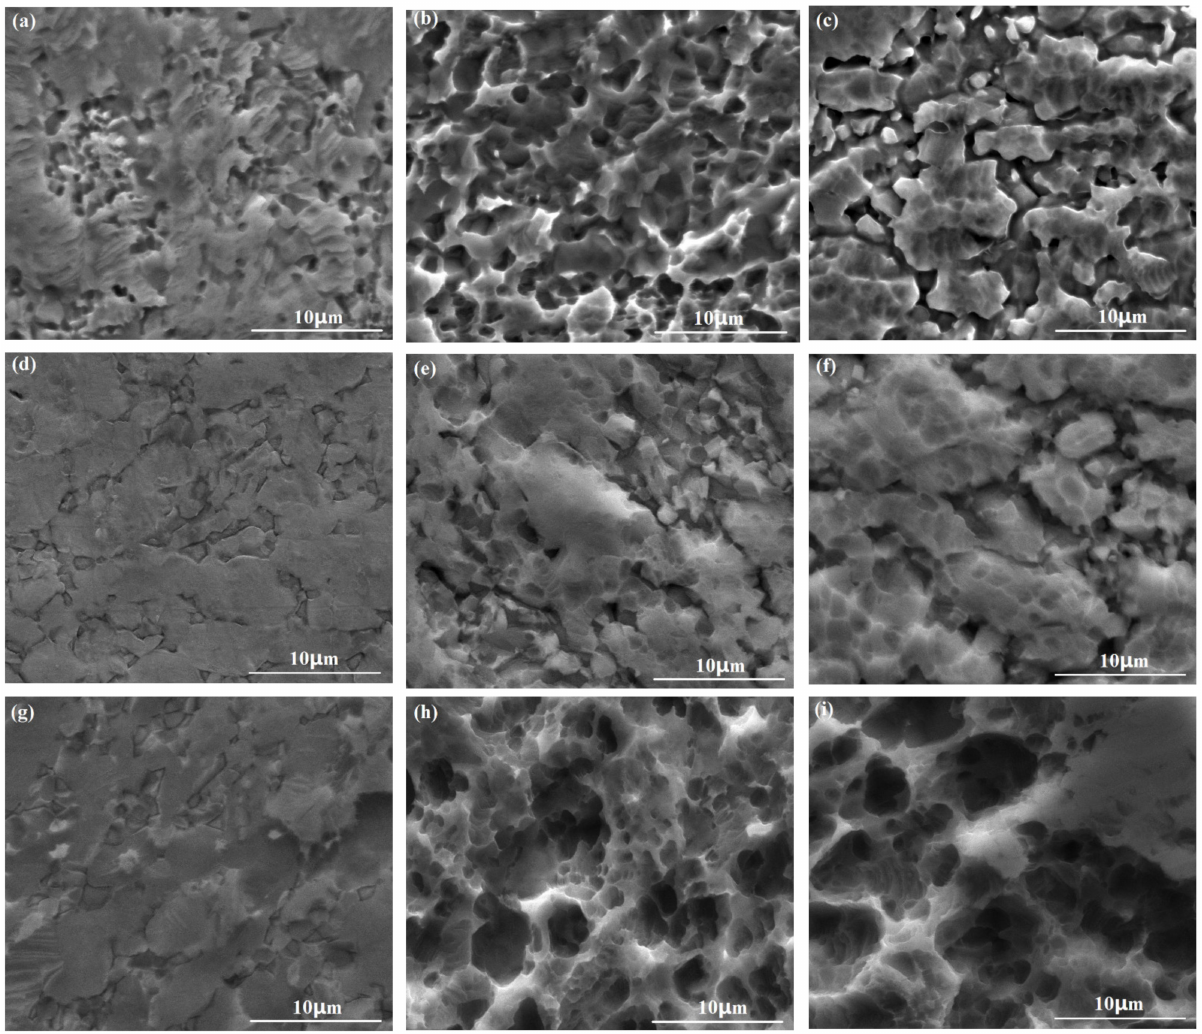
Figure 15. Corroded morphologies of the TC4 alloy after potentiostatic polarization at 100 mV